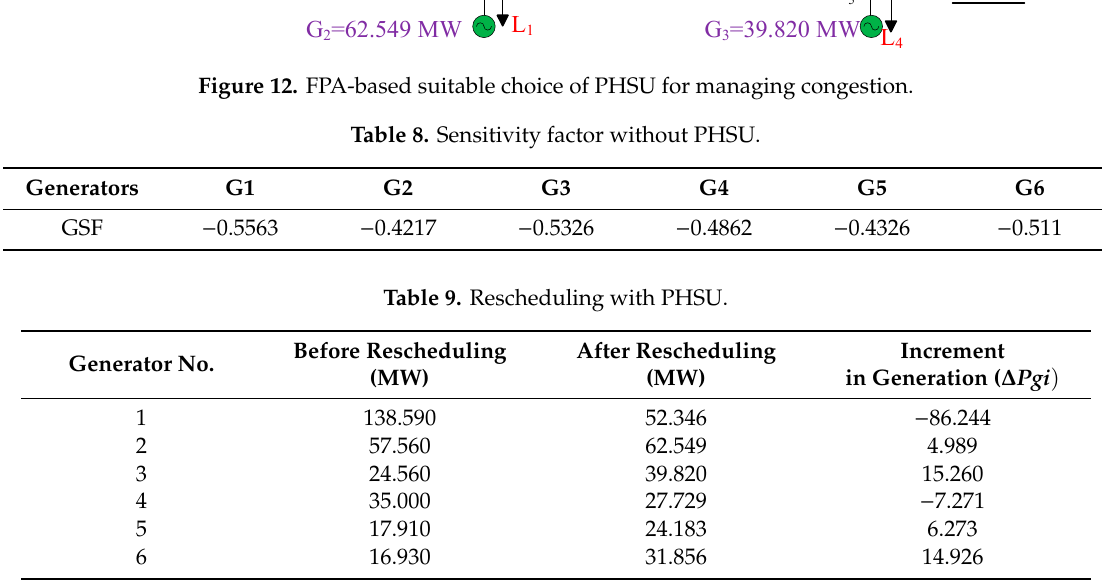
Table 9. Rescheduling with PHSU.